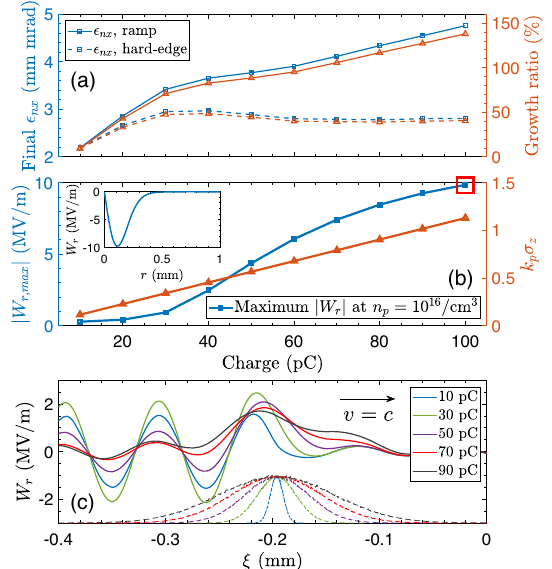
FIG. 11. (a) Final emittance and its growth ratio as a function of electron beam charge. The bunch length was varied to maintain the peak current same for all cases. Solid and dashed lines indicate the cases with and without the plasma density ramp, j value (blue curve) at the center respectively. (b) Maximum j W r of the electron beam slice obtained by Eq. (8) with plasma density ¼ 1 × 10 16 = cm 3 . Inset shows the transverse wakefield along r n p in the case of 100 pC charge (red box). In this theoretical calculation, only the electron beam is considered. Orange curve σ shows the resonant condition k . (c) Transverse wakefields p z along the electron slice distribution with different charges obtained by the PIC simulation. Dashed Gaussian histograms are the longitudinal beam distributions. Here, the electron beam is moving through the flat region of the